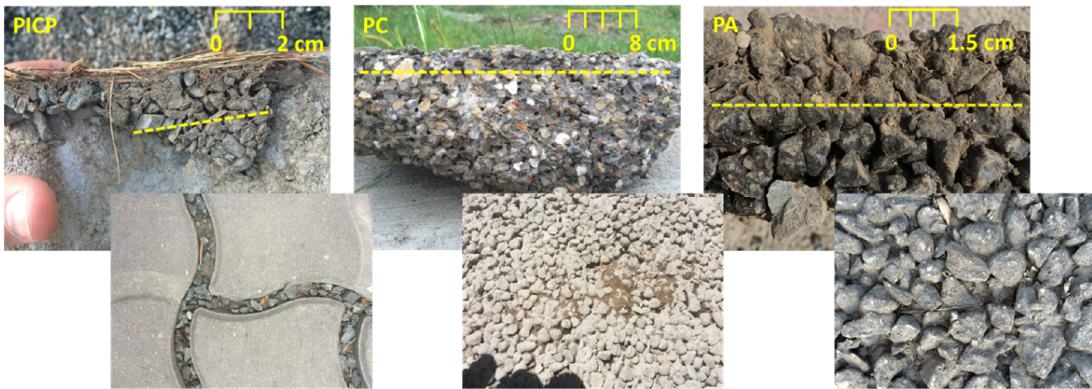
Figure 9. Photographs of the sediment captured in the profiles and on the surfaces of the permeable interlocking pavers (PICP), pervious concrete (PC), and porous asphalt (PA) (the dashed line indicates sediment penetration depth; lower images not to scale).